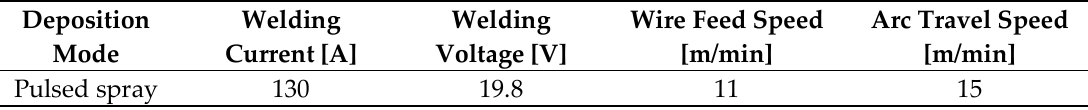
Table 1. Constant parameters for pulsed spray mode.